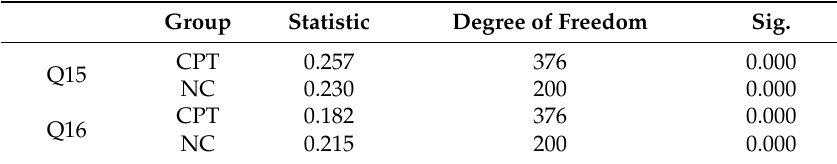
Table 7. Results for Kolmogorov–Smirnov test.